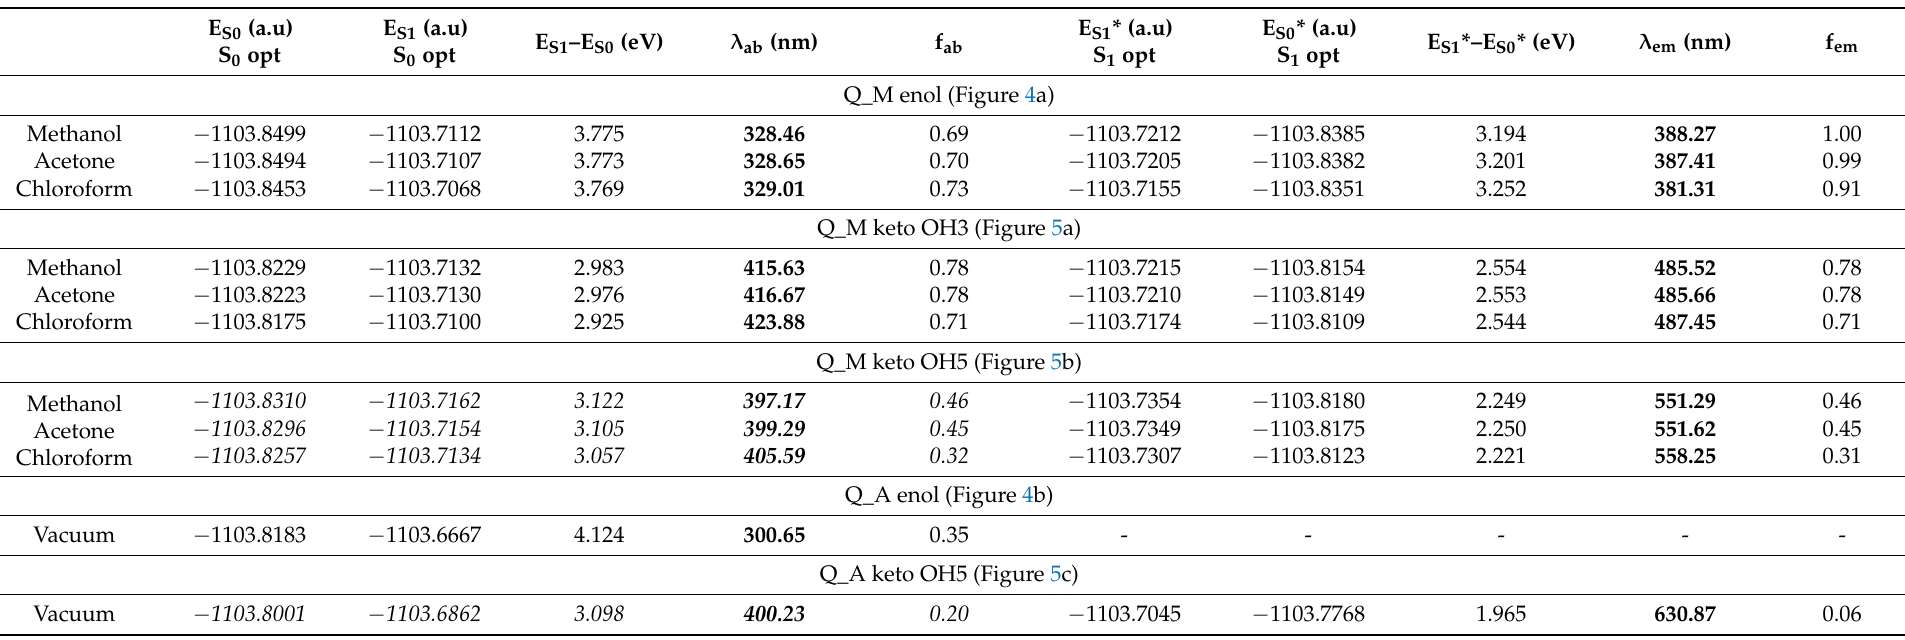
Table 1. Absorption and emission of Q molecule obtained at TDDFT-M06-2X/6-31++G(d,p) level of